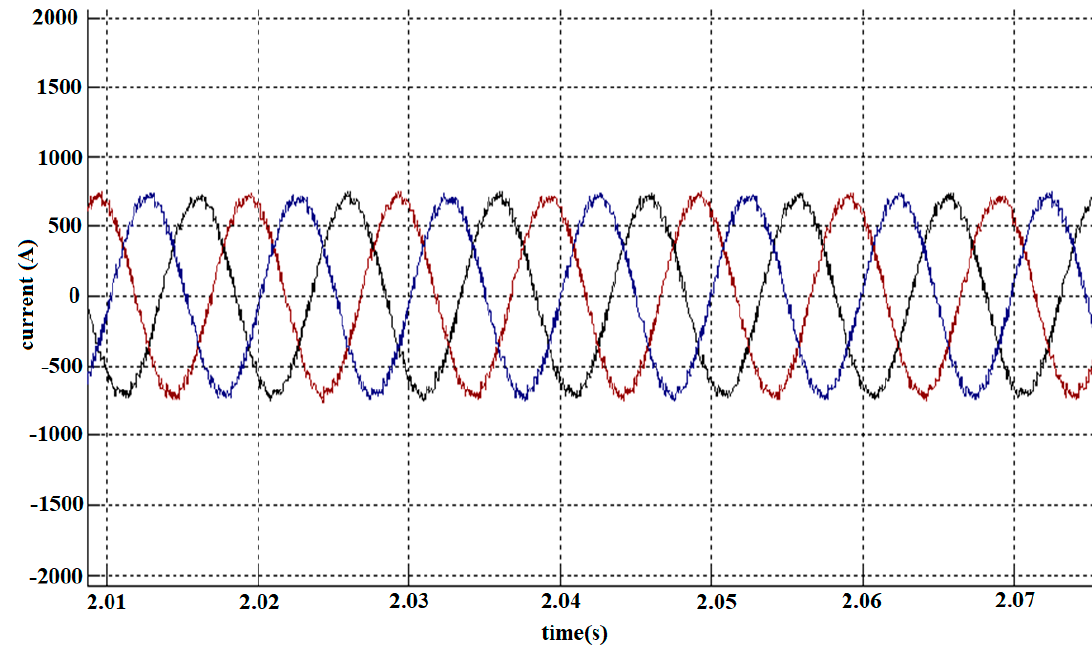
Figure 26. Rotor current of induction motor.